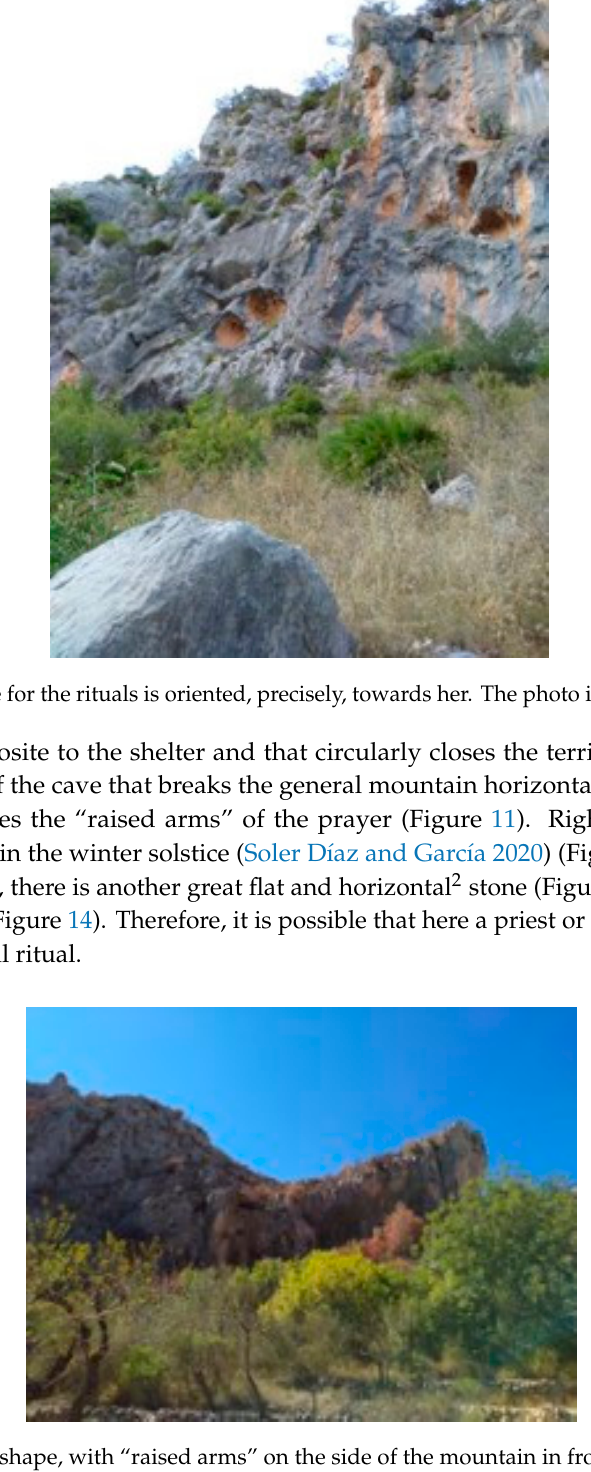
Figure 9. Under the prayer, there is a stone for the rituals. The photo is taken by the author.